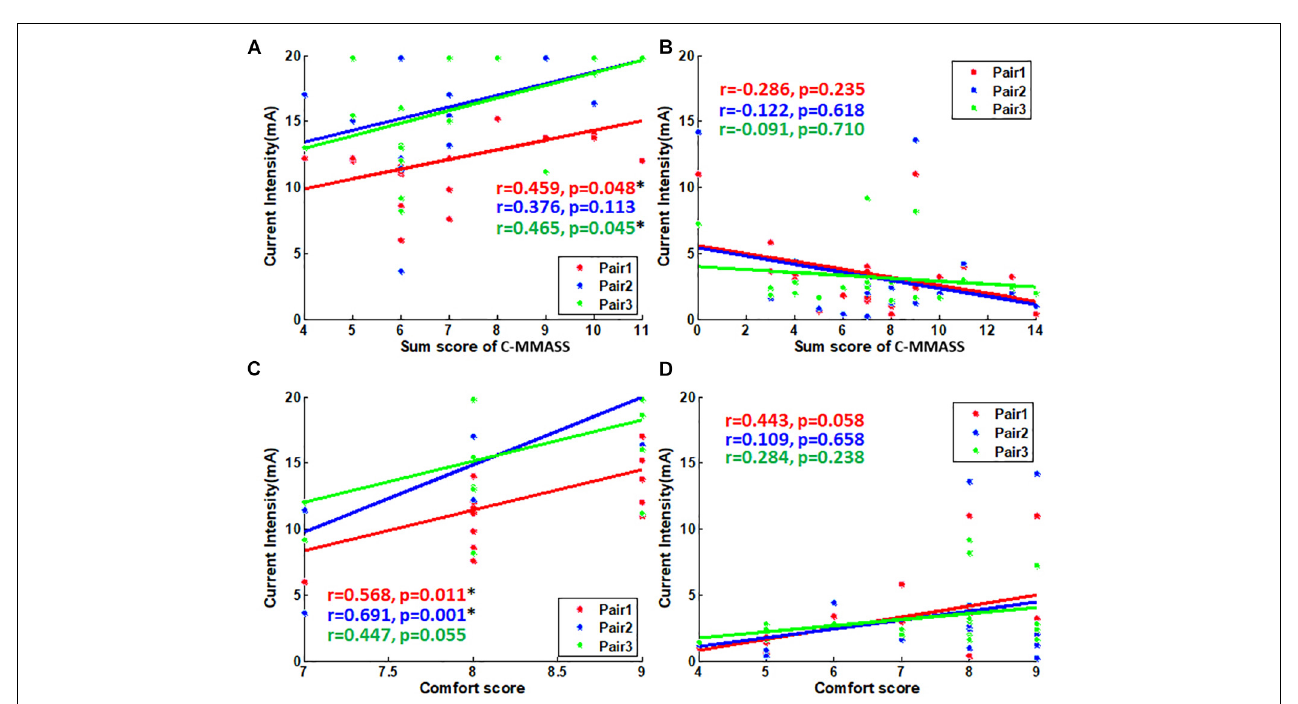
FIGURE 7 | The scatter plot of scores vs. tolerability threshold. (A) The scatter plot of C-MMASS sum scores vs. TENS current intensities. (B) The scatter plot of C-MMASS sum scores vs. EA current intensities. (C) The scatter plot of comfort scores vs. TENS current intensities. (D) The scatter plot of comfort scores vs. EA current intensities. * P <